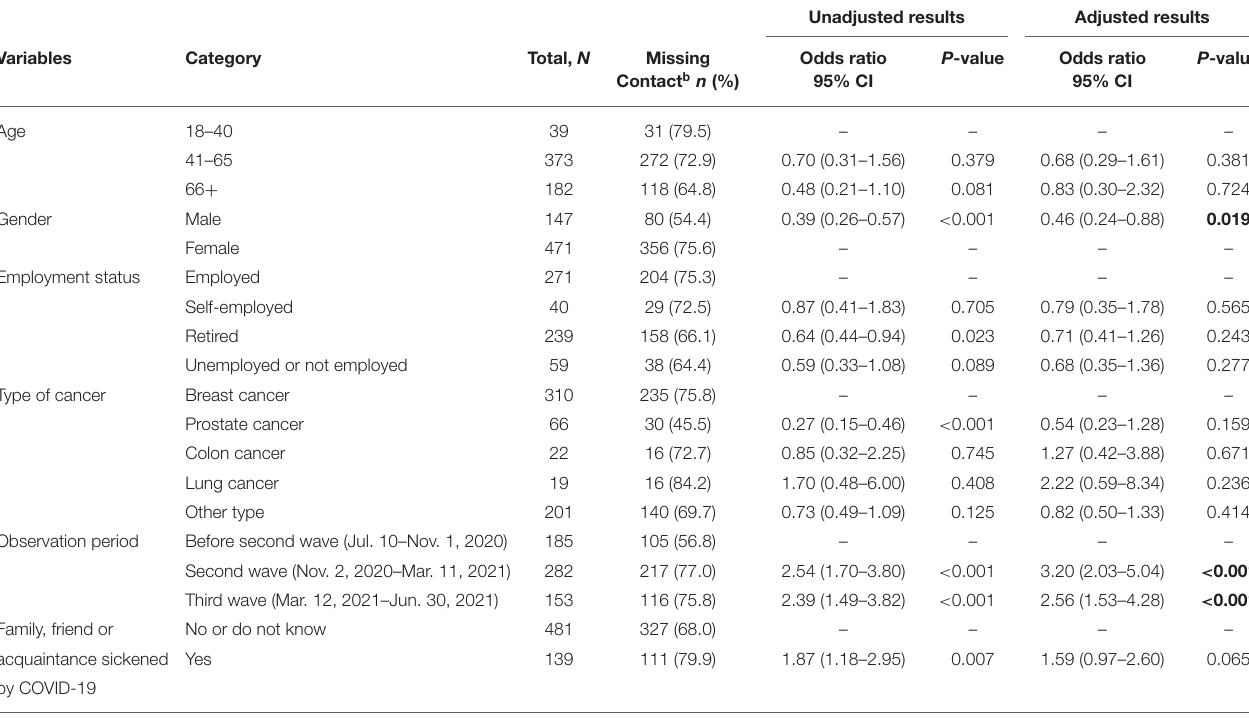
TABLE 6 | Logistic regression of associated factors for patient missing contacts with relatives, friends, work colleagues, neighbors a